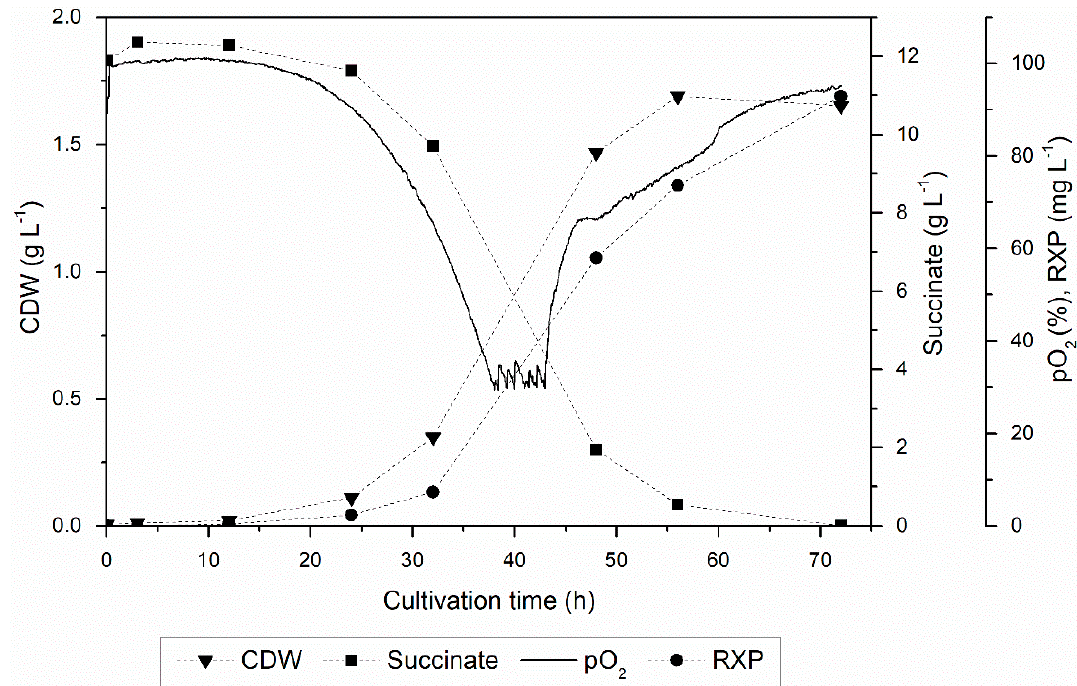
Figure 2. Kinetic profile of RXP production, showing CDW, succinate concentration, RXP concentration and oxygen partial pressure in a 5 L batch process.